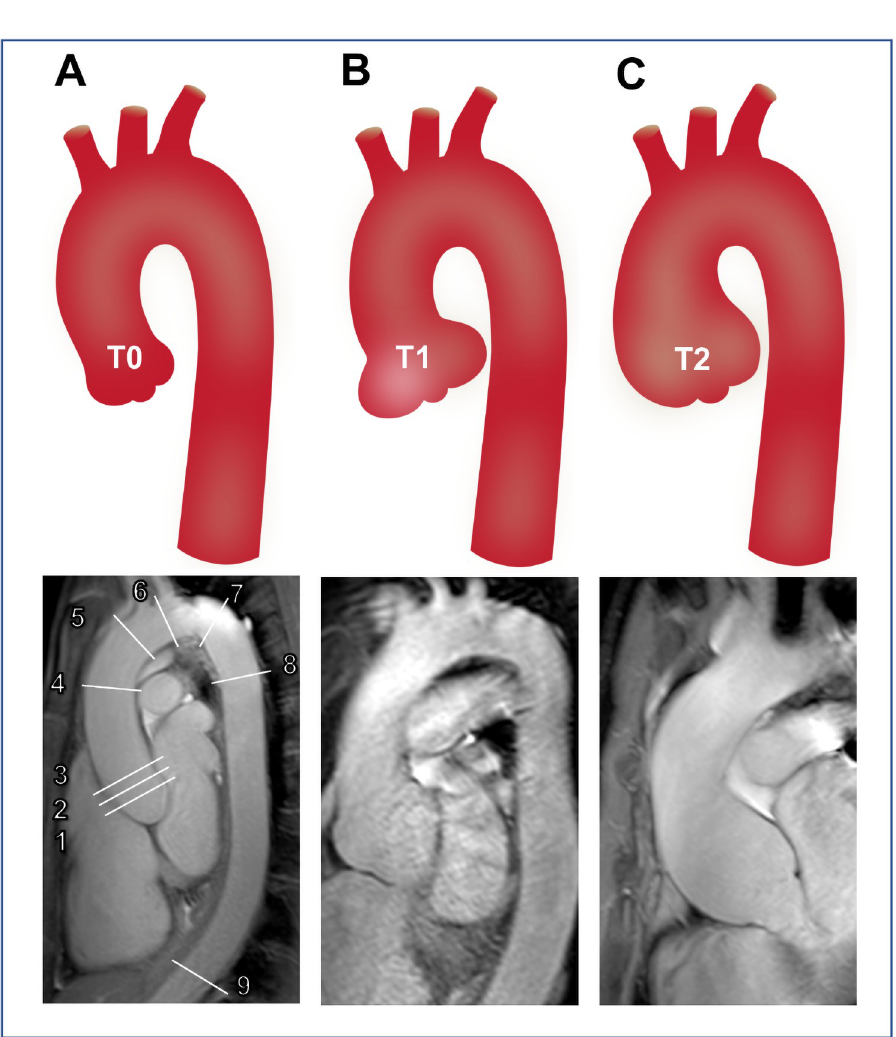
Fig 1. Illustration of different aortic root shapes (upper panels) in Marfan patients and corresponding MR angiography (lower panels). (A) normal shape of the aortic root without dilatation (T0). (B) Localized aortic root dilatation, which is confined to the sinuses of Valsalva (T1). (C) Generalized aortic root dilatation with extension beyond the sinotubular junction (T2). MR angiography in para-sagittal orientation of Marfan patients with (A) normal shape of the aortic root without dilatation (T0), (B) Localized aortic root dilatation (T1), and (C) generalized aortic root dilatation (T2). Diameter measurements were performed at the level of the aortic annulus (1), sinuses of Valsalva (2), sinotubular junction (3), mid ascending aorta at the pulmonary artery bifurcation (4), at the innominate artery (5), aortic arch between the left common carotid and left subclavian artery (6), proximal descending aorta at isthmus, 2 cm distal to left subclavian artery (7), mid descending aorta (at pulmonary artery bifurcation) (8), and thoraco-abdominal aorta at the level of the diaphragm (9). Of note, readers were presented the entire para-sagittal stack of images and were free to choose appropriate slices displaying the maximal profile of the